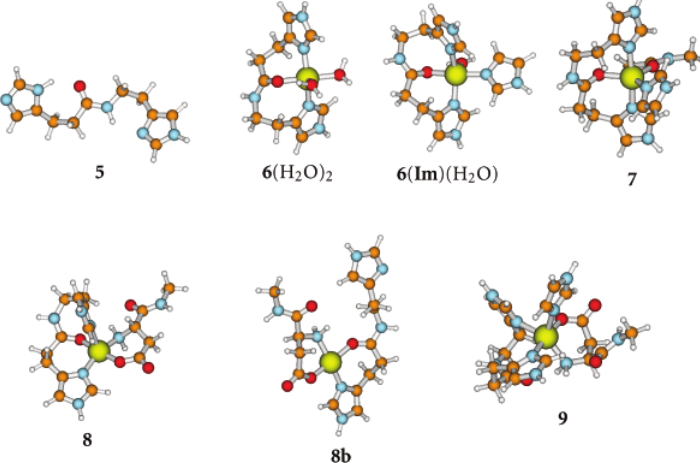
Figure 3: Structures with Cu(II), HisHis 5 , Asp1, and Imidazole Im . Ball colors: Cu = large yellow; C = orange; N = blue; O = red; H = white.